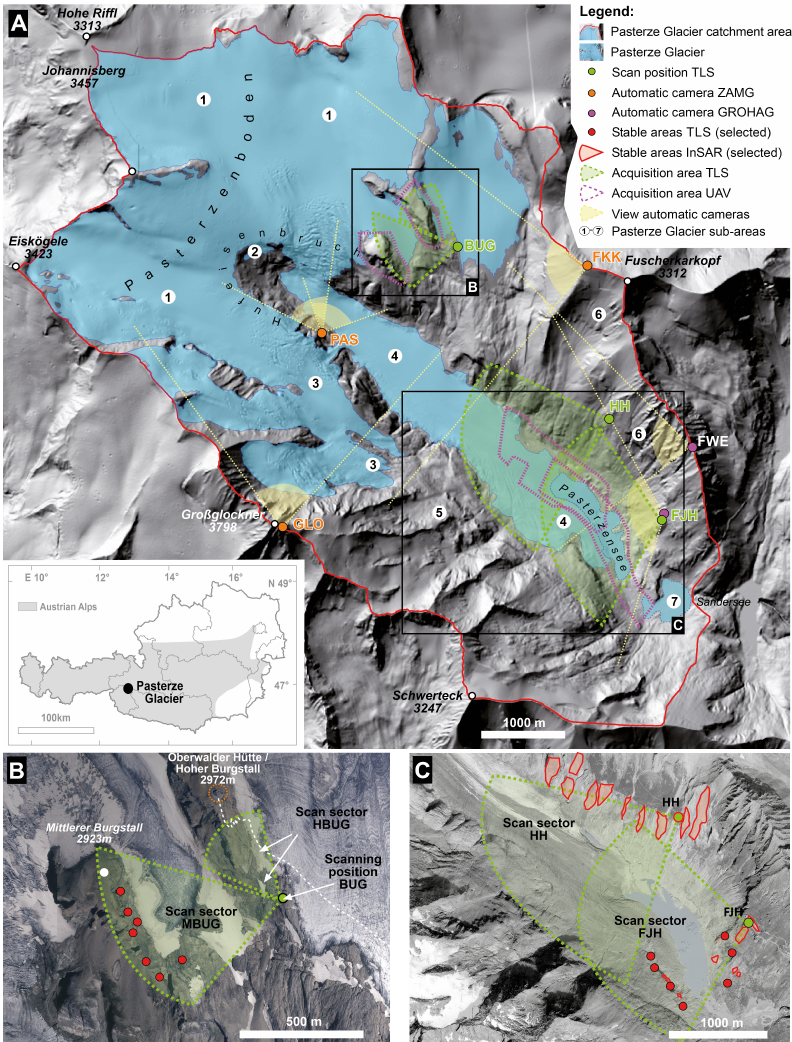
Figure 1. Study area Pasterze Glacier. ( A ) Catchment area Pasterze Glacier area with respective codes for Pasterze Glacier sub-areas (1–7); location of automatic cameras and TLS scanning positions; acquisition areas for TLS and UAV; and view sectors of automatic cameras. ( B ) TLS configuration Burgstall rock fall area (BUG). Red dots indicate stable areas for TLS quality assessment. ( C ) Situation at the Pasterze Glacier terminus and proglacial area. TLS configuration Franz- Josefs-Höhe (FJH) and Hofmanns Hütte (HH). Red areas indicate stable areas for DInSAR quality assessment, red dots stable areas for TLS quality